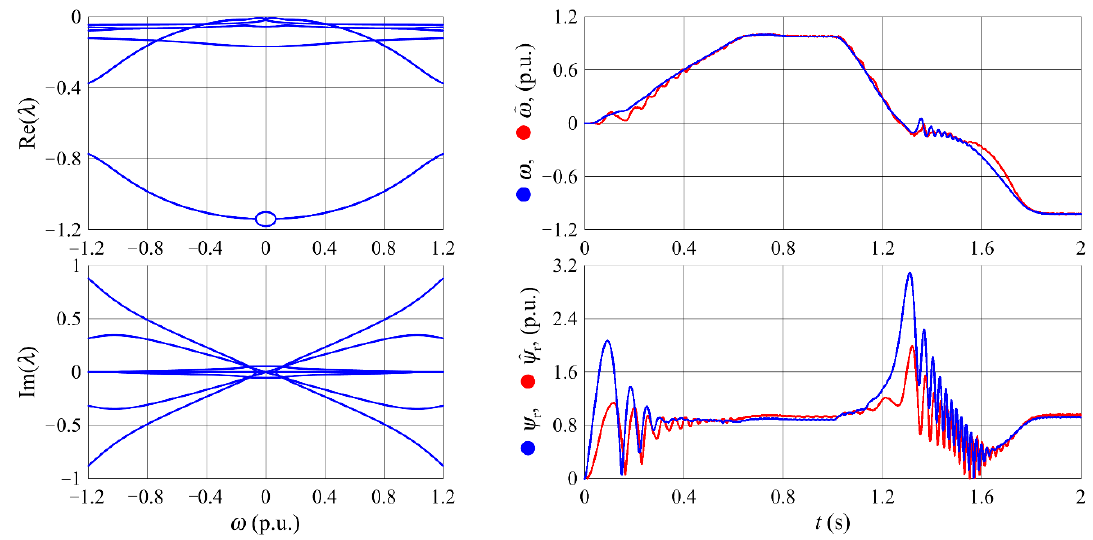
Figure 11. The eigenvalues and simulation results obtained for the observer with two ( v = 2) additional integrators.